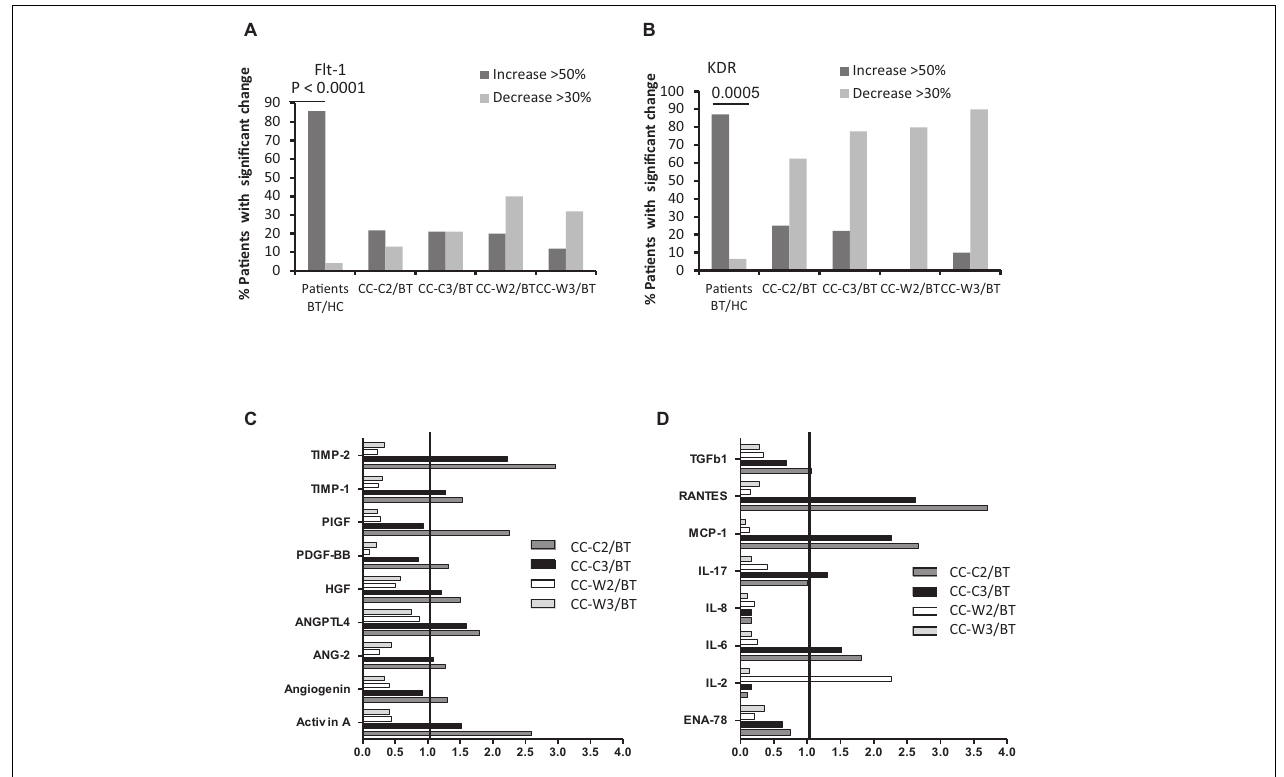
FIGURE 6 | EVs expression of VEGF-receptors (Flt-1, KDR) and cytokine contents. Levels of growth factors receptors were measured on EVs obtained from healthy controls and on EVs obtained from patients at three time points, using specific fluorescent antibodies; The graph presents significant changes ( > 50% increase or > 30% decrease) in patient EVs levels BT compared to HC and the change during treatment and at the end of chemotherapy treatment compared to the levels BT related to A . VEGFR1 (Flt-1) (A) , VEGFR2 (KDR) (B) . EV proteins extract, obtained from a pool of five specimens within each patient subgroup, were validated by Human Angiogenesis Protein Antibody Array. The graph presented the change in specific EVs cytokine and growth factors content during treatment compared the EVs content before treatment. Growth factors (C) and inflammatory cytokine (D)